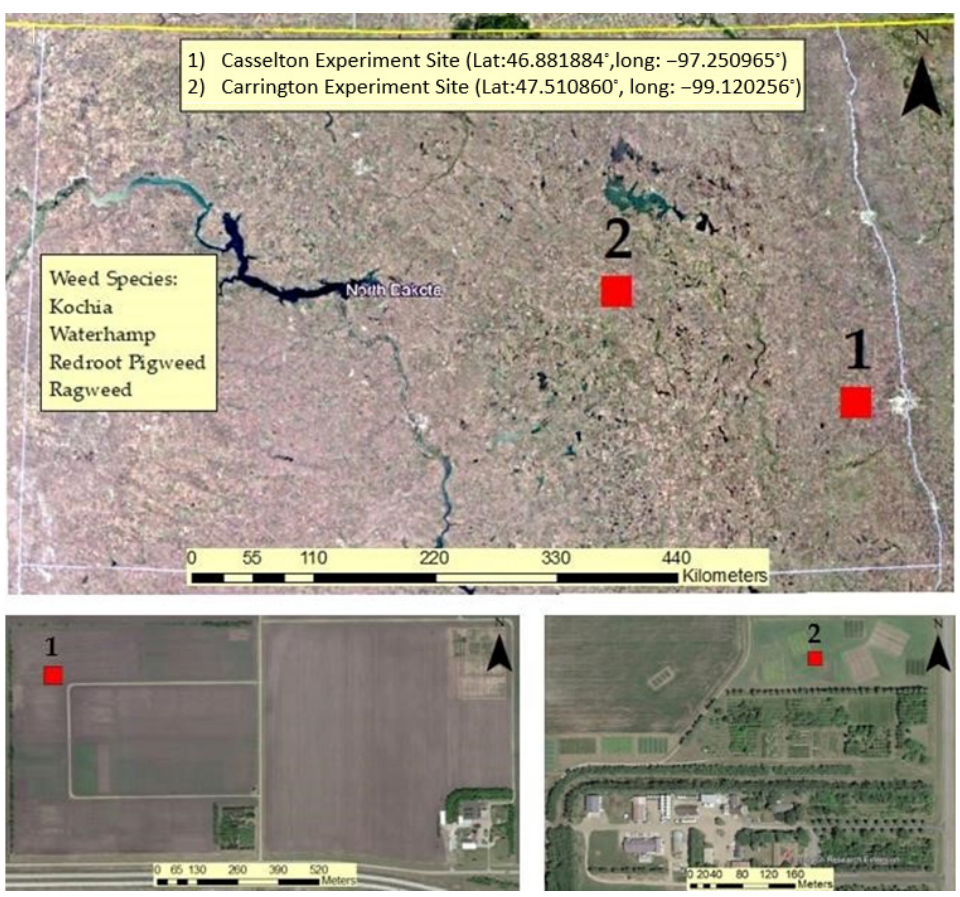
Figure 1. NDSU experiment sites represented in maps including weed species (top); ( 1 ) Casselton experiment site ( bottom left ) and ( 2 ) Carrington Experiment site ( bottom right ).